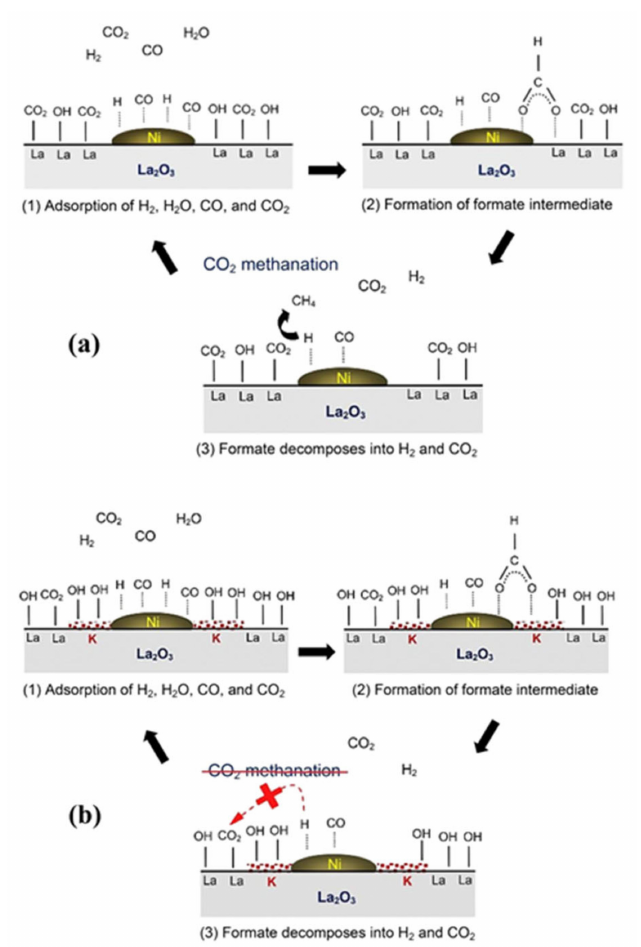
Figure 14. The mechanism of alkali metals improving the selectivity of water-gas shift (WGS) [171]. ( a ) the reduced LaNiO 3 perovskite catalyst and ( b ) the reduced K-doped LaNiO 3 perovskite catalyst. Copyright 2017,